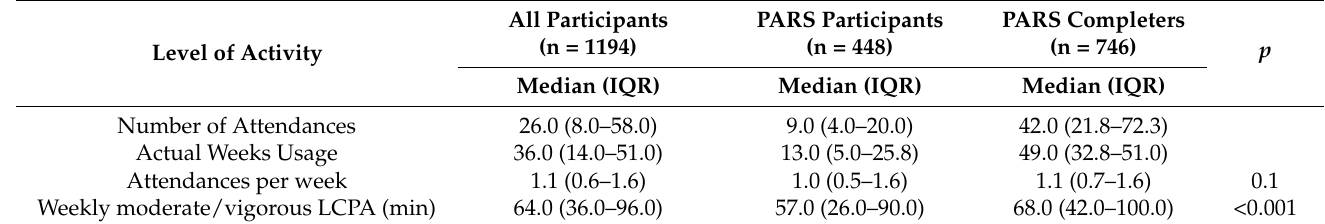
Table 5. Overall attendance and actual weeks usage.